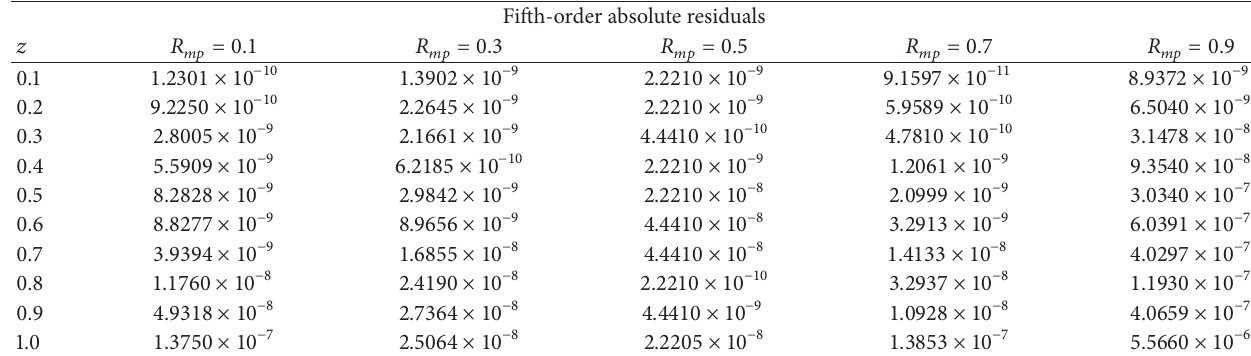
Table 2: Absolute residuals for different 𝑅 𝑚𝑝 keeping 𝑚 ℎ and 𝑚 𝑝 fixed.